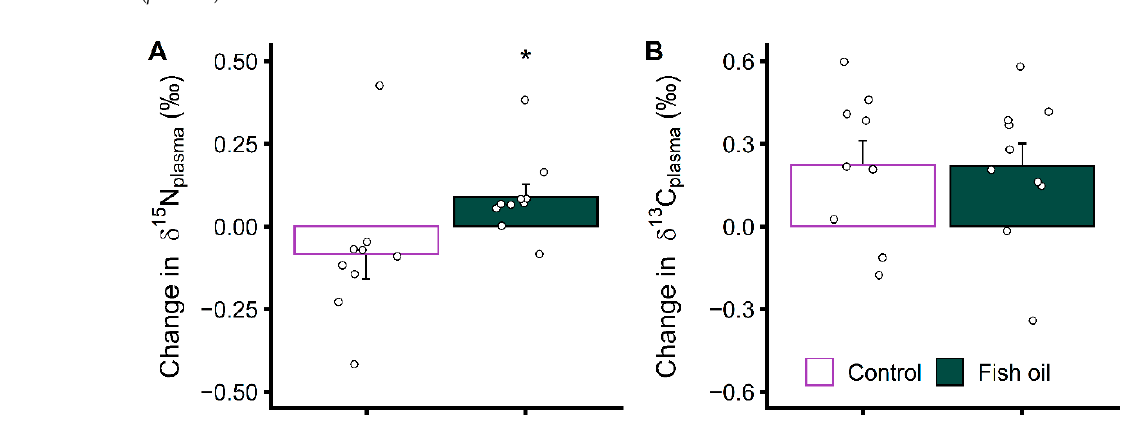
Figure 6. Early changes in plasma δ 15 N ( A ) and δ 13 C ( B ) in a subsample of advanced breast cancer patients who complied with fish oil supplementation ( n = 10) or with a control supplementation ( n = 9). Changes in δ 15 N and δ 13 C are the differences between the δ values at 10 days and those at baseline, calculated to normalize the impact of dietary input and isolate the effect of